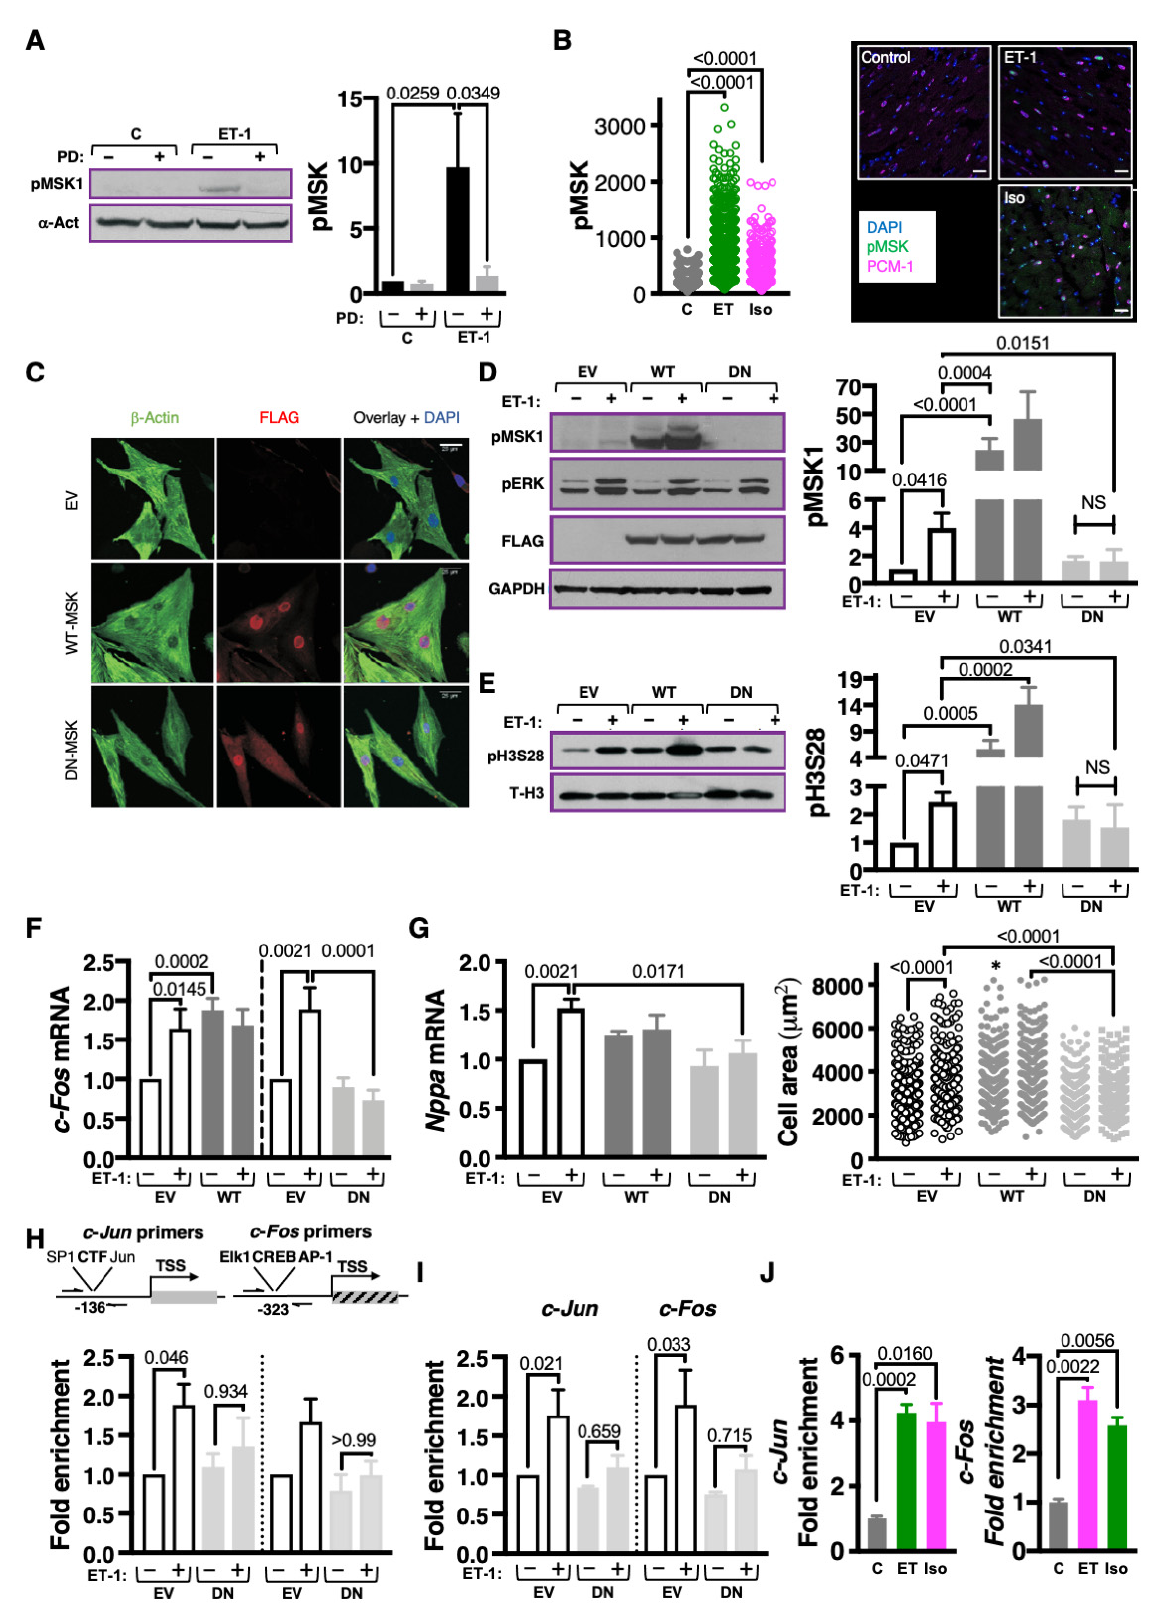
Figure 2. Activated MSK is required for histone H3S28 phosphorylation, recruitment of BRG1 to chromatin and IEG induction in CM. ( A ). Immunoblot showing levels of phosphorylated (activated) MSK in NRVMs +/ − PD and stimulated +/ − ET-1 for 10 min. pMSK is normalised to α -Actinin ( α - Act) as a loading control. Left: Representative immunoblot. Right: Quantification of pMSK relative